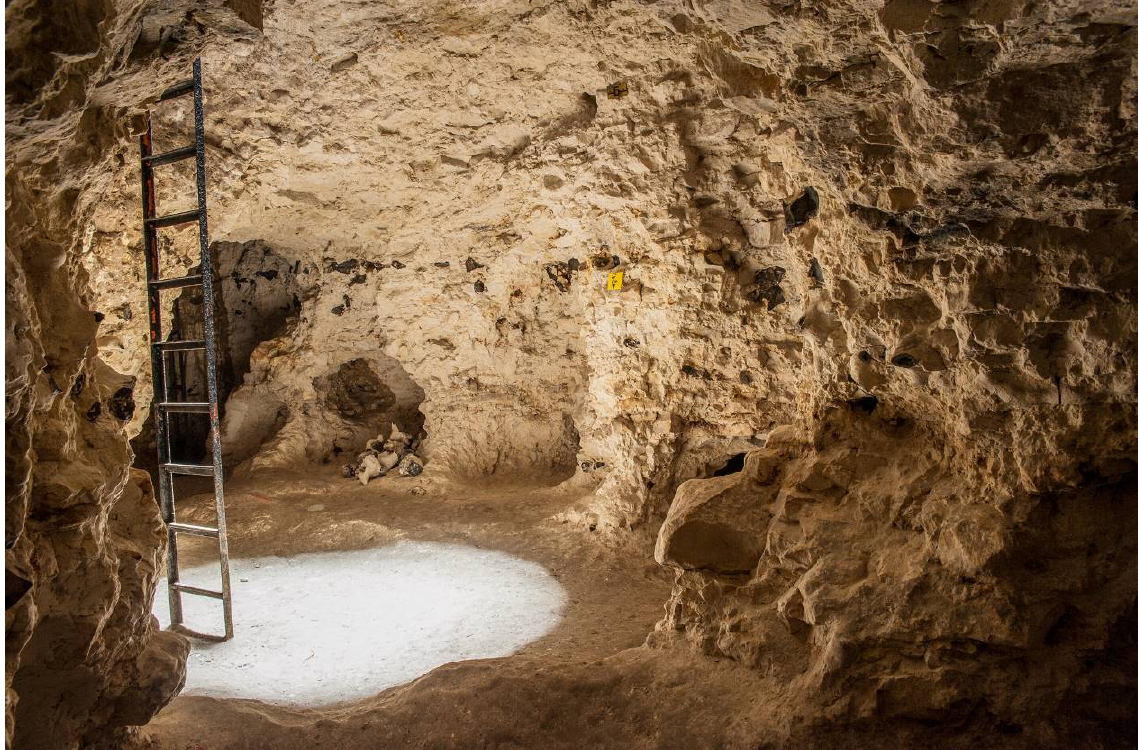
Figure 13. Petit-Spiennes flint mines, excavated by the SRPH from 1953 to 2003. Photo by M. Woodbury,